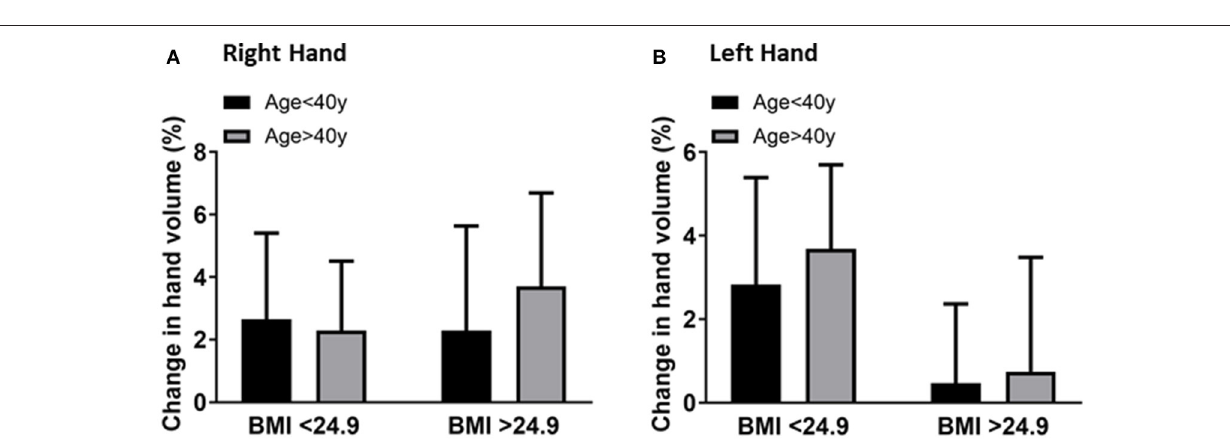
FIGURE 4 | Comparison of the right-hand volume changes (A) and left-hand volume changes (B) by BMI ( < 25 vs. ≥ 25) after 20min of hand immersion in water. Values are means ± SD. n =